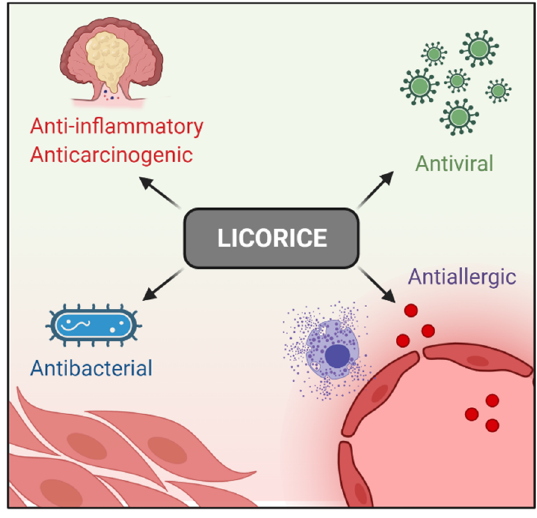
Figure 1. Licorice pharmacological properties.